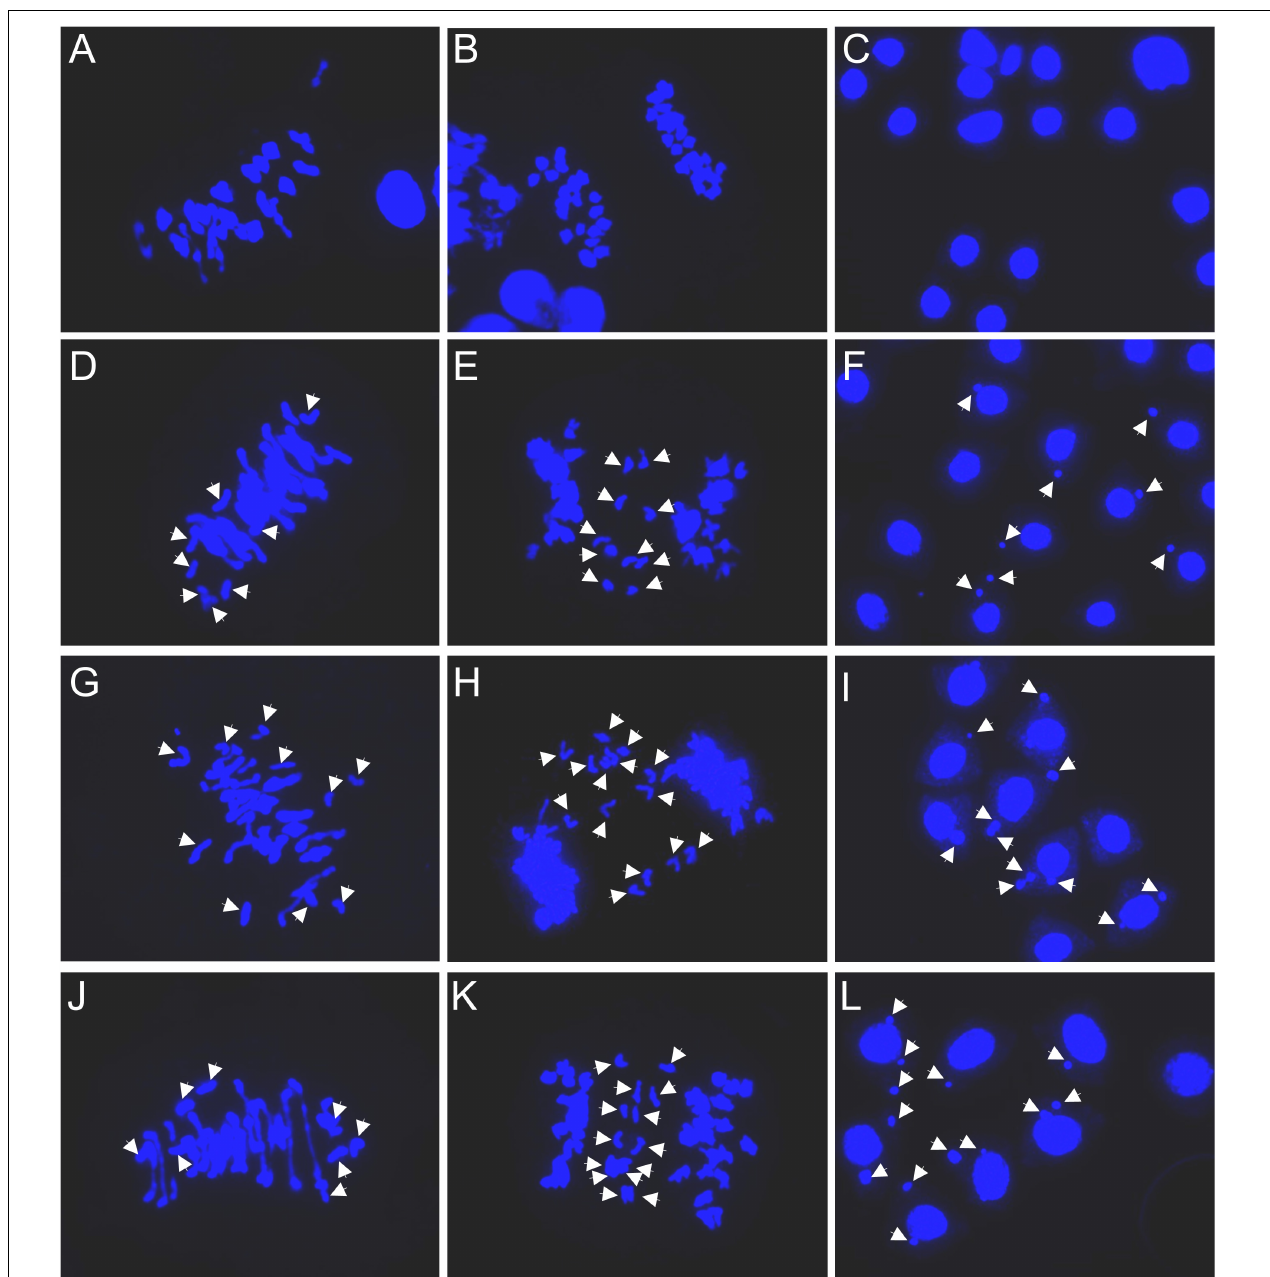
FIGURE 2 | Meiotic observations: (A–C) Chuanmai 32; (D–F) SHW-L1; (G–I) SHW-L1/Chuanmai 32 F 1 ; (J–L) Chuanmai 32/SHW-L1 F 1 . (A,D,G,J) are metaphase I. (B) ; (E,H,K) are at ana-/telophase I; (C,F,I,L) are tetrads. White arrows indicate univalents (D,G,J) , separation of chromatids in first division (E,H,K) , and micronuclei (F,I,L)